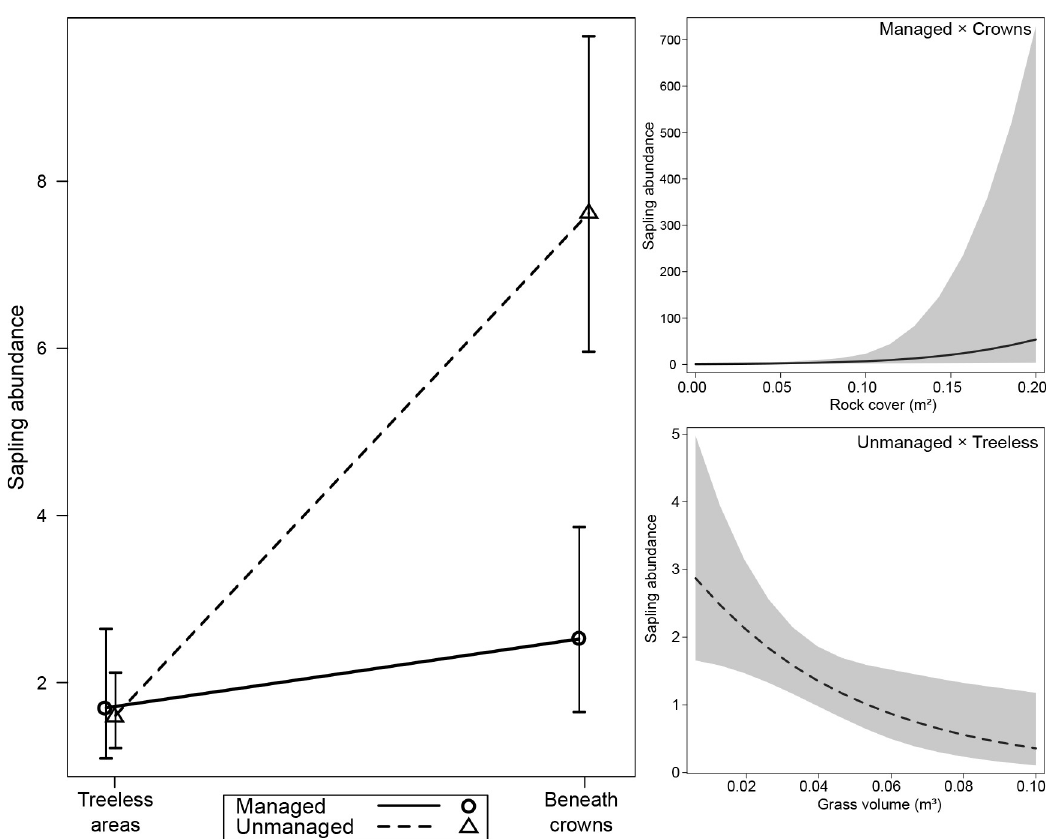
Fig 2. Abundance of saplings (individuals per m 2 ) in relation to land management, araucaria crown influence and covariates (grass volume and rock cover) in an upper-montane Araucaria forest, southern Brazil. Shaded areas represent 95% confidence intervals. Effects of land management and araucaria crown influence on abundance were plotted without the effects of covariates (rock cover and grass volume). Effects of rock cover and grass volume on abundance were plotted from a GLM.